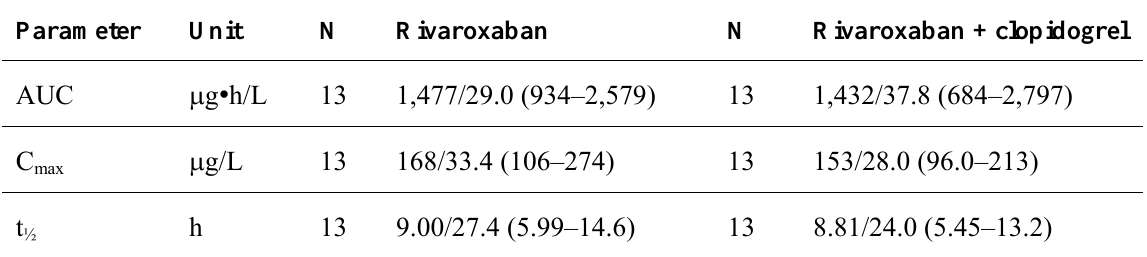
Table 1. Pharmacokinetic parameters in plasma following a single oral dose of 15 mg rivaroxaban alone or in combination with 75 mg clopidogrel [geometric mean values/%CV (range), N = 13]. AUC: area under the concentration-time curve; C : terminal concentration; t ½